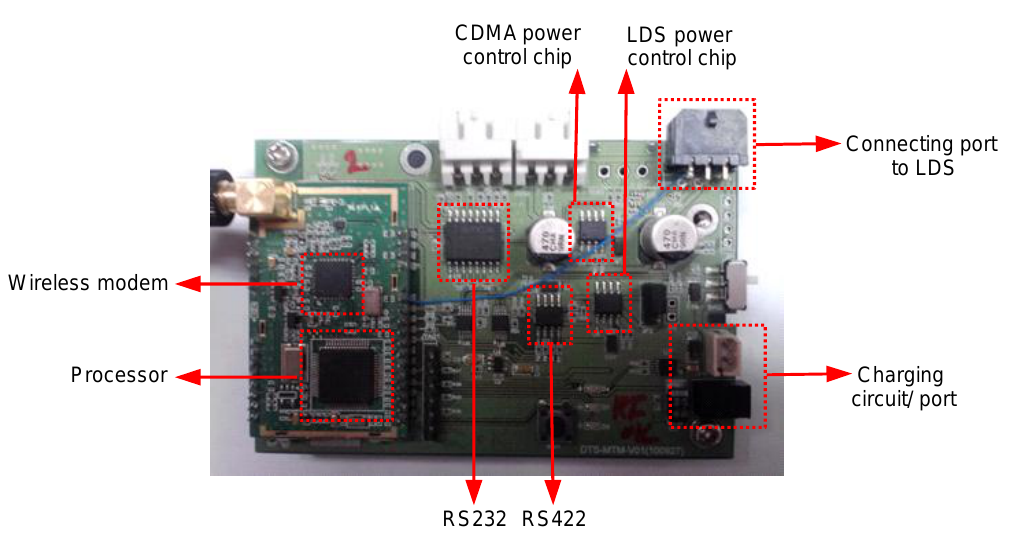
Figure 2. Wireless laser displacement sensor node.